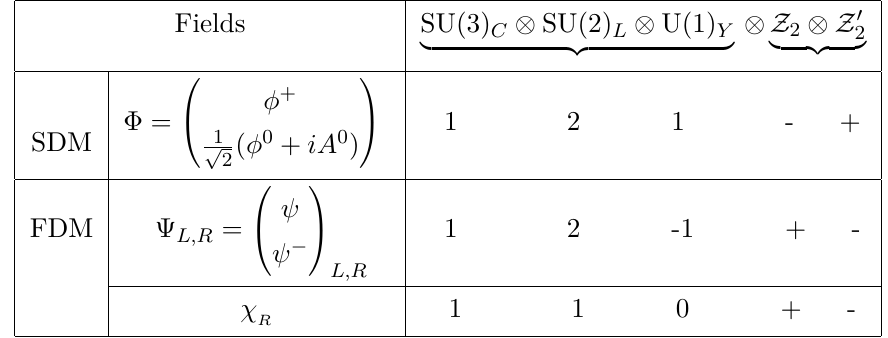
Table 1. Charge assignment of the BSM fields under the gauge group G ≡ G SM ⊗ G DM in the toy scenario. Here G